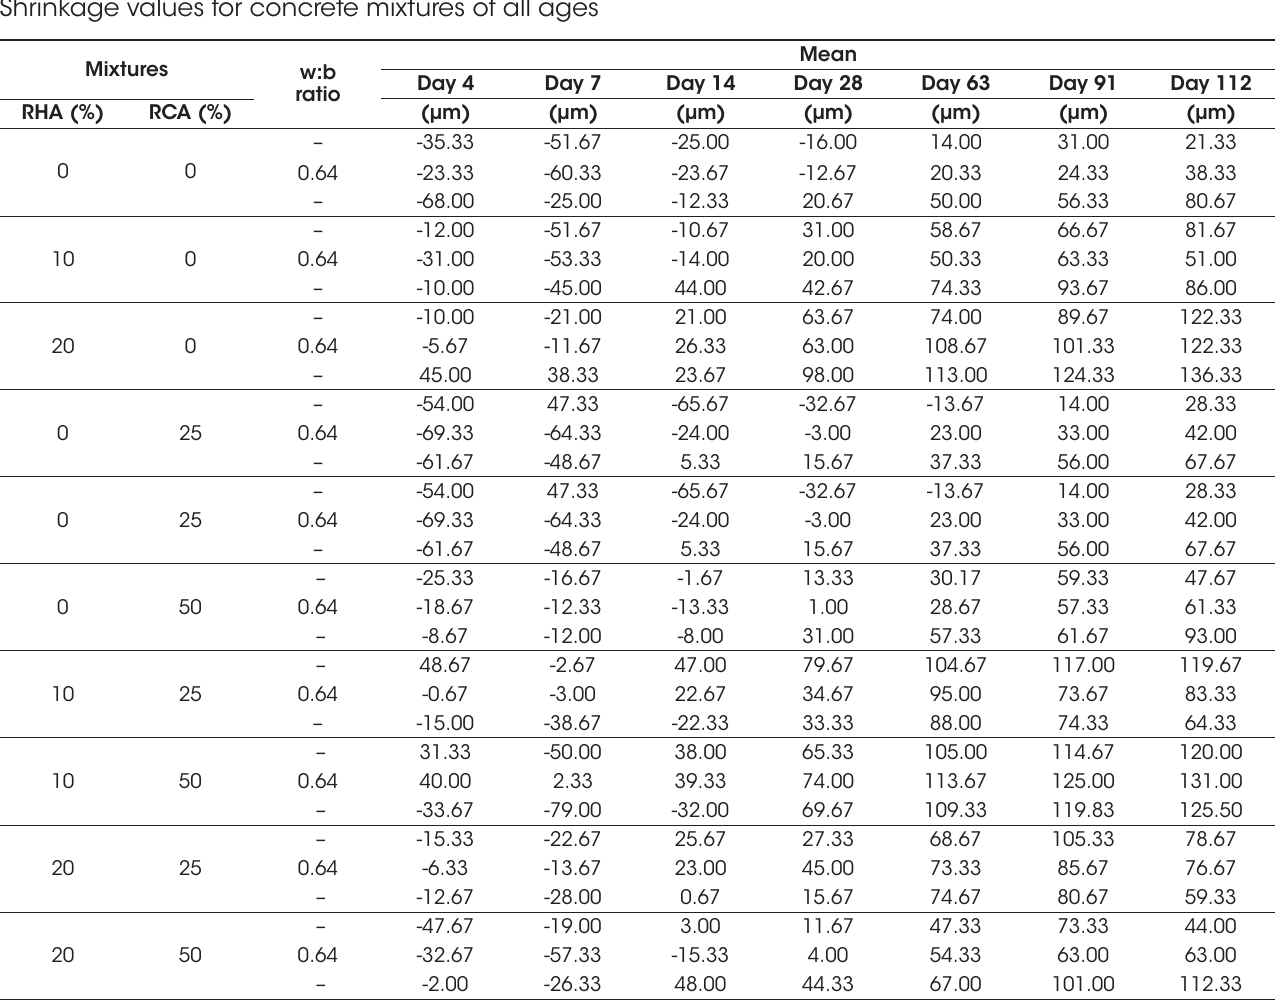
Shrinkage values for concrete mixtures of all ages